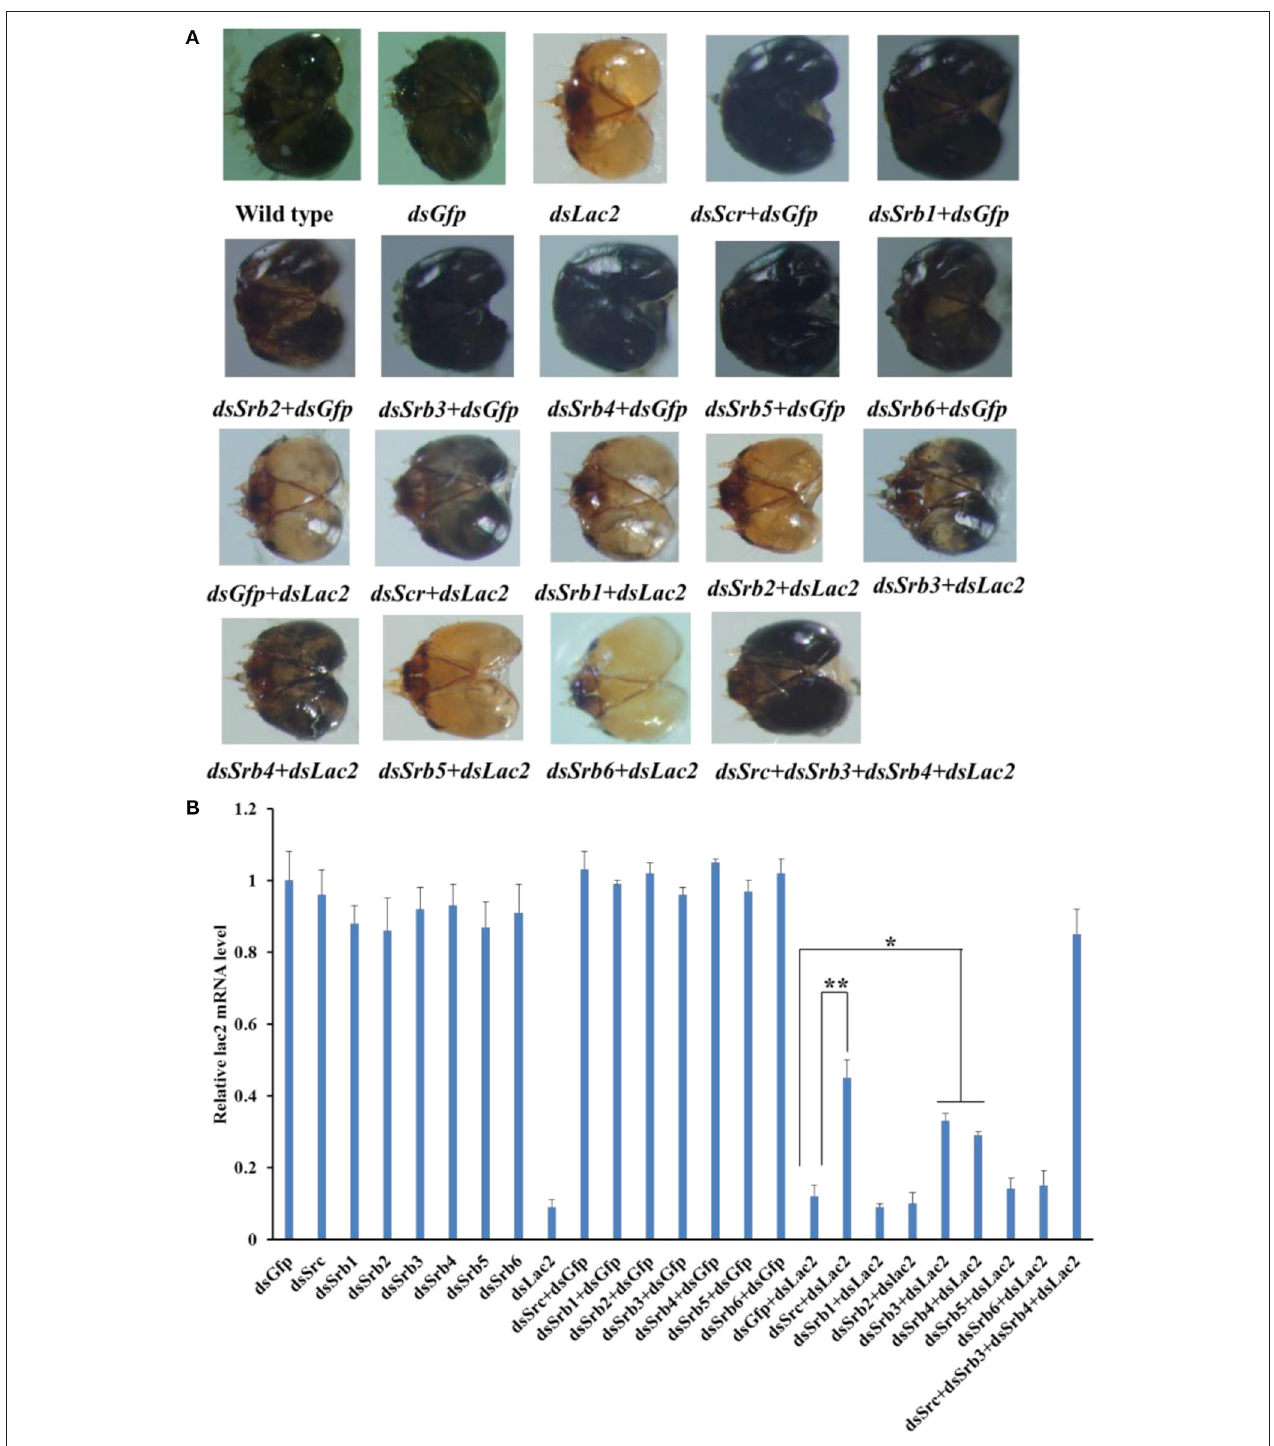
FIGURE 14 | Involvement of scavenger receptors C and B (Src and Srb) in dsRNA uptake by the soybean pod borer. (A) Heads of a wild-type larva as well as larvae fed Gfp dsRNA, Lac2 dsRNA, Src dsRNA + Gfp dsRNA, Srb dsRNA + Gfp dsRNA, Gfp dsRNA + Lac2 dsRNA, Src dsRNA + Lac2 dsRNA, or Srb dsRNA + Lac2 dsRNA. Treatments with 5 µ g/ml Src , Srb3 , or Srb4 dsRNA suppressed the Lac2 RNAi. A simultaneous treatment with 5 µ g/ml Src , Srb3 , and Srb4 resulted in a complete rescue of the phenotype. (B) Relative Lac2 expression level based on a qRT-PCR. All data were normalized against the Lac2 expression levels in the control larvae fed Gfp dsRNA + Lac2 dsRNA. Data were analyzed using Student’s t -test (** p < 0.01; * p < 0.05).